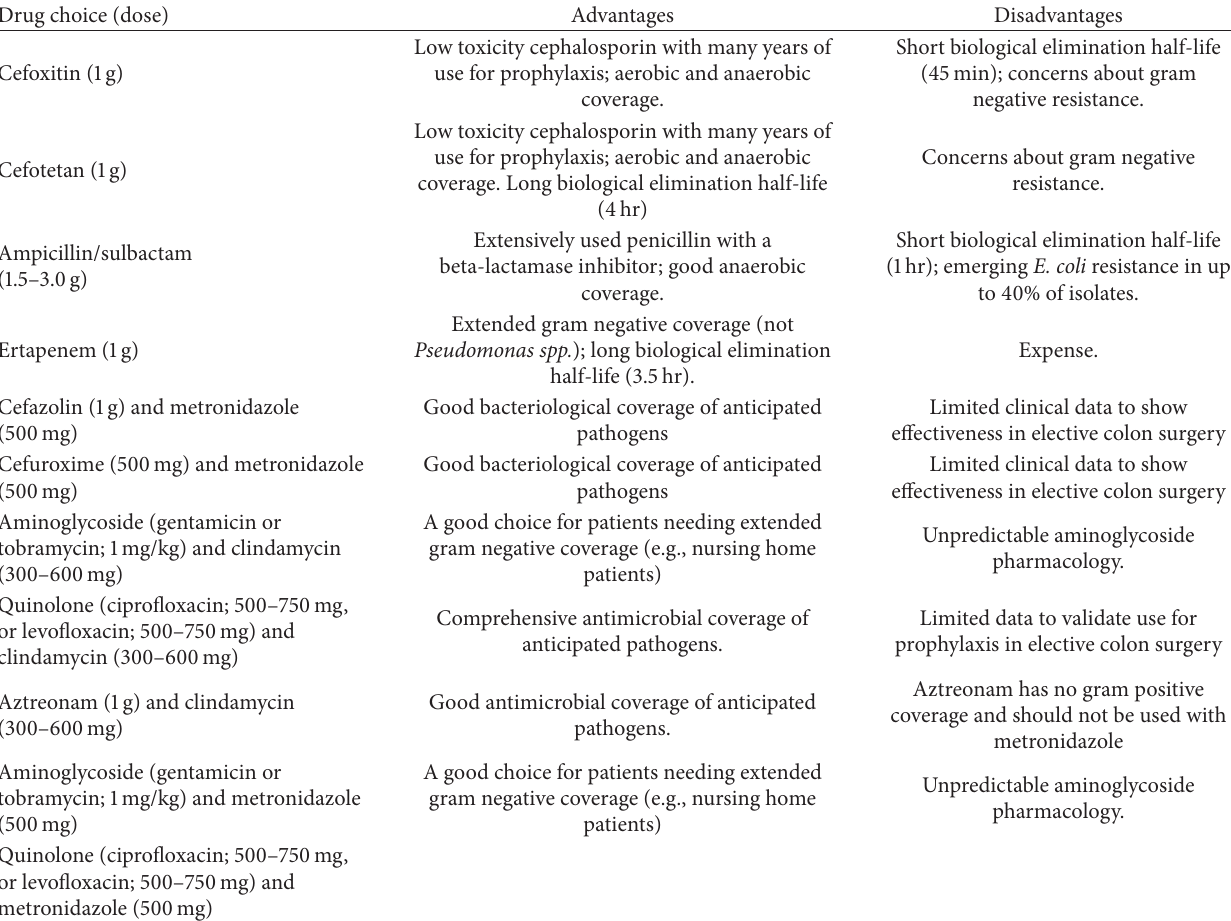
Table 4: These are the preventive antibiotic choices that are currently recommended by the Surgical Care Improvement Project. The advantages and disadvantages are the authors